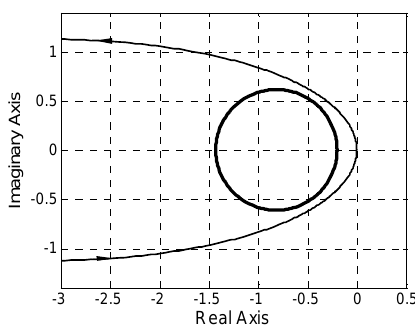
Fig. 14. Disk Fig. 15. Step responses of an unstable plant with the